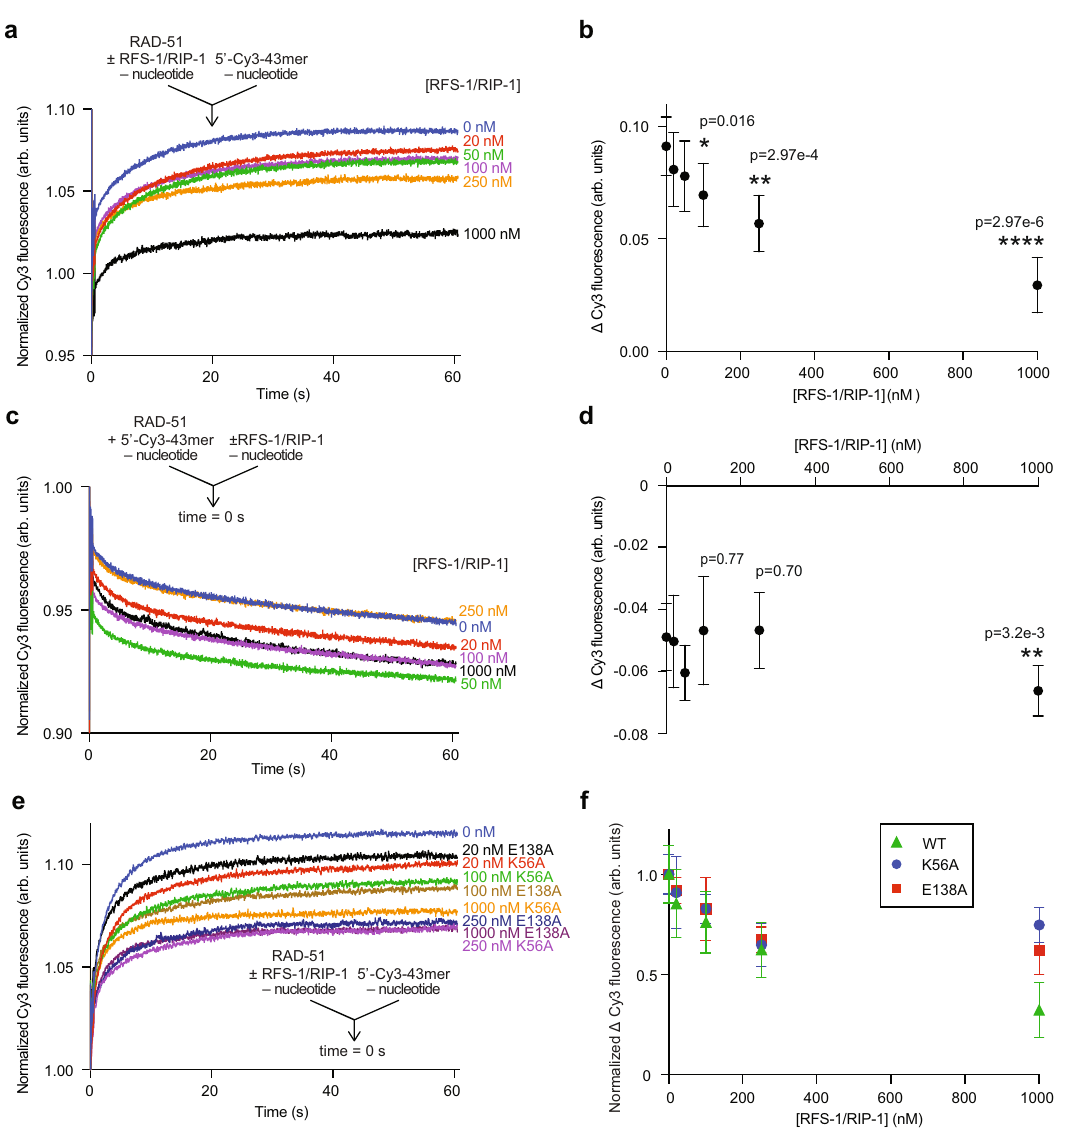
Fig. 2 RFS-1/RIP-1 inhibits the binding of RAD-51 to ssDNA in the absence of nucleotide cofactors. Average normalized Cy3-43mer fl uorescence pro fi les plotted as a function of time. The arrow indicates the components of the two syringes rapidly mixed at the 0 s time point in a stopped fl ow instrument. RAD-51 (1 μ M) was either pre-mixed with increasing amount of RFS-1/RIP-1 and then was mixed with 15 nM Cy3-43mer ssDNA ( n = 6 – 7) ( a ) or RAD-51 was pre-mixed with ssDNA and afterwards mixed with RFS-1/RIP-1 in the absence of nucleotide and analyzed in stopped fl ow machine ( n = 7 – 8) ( c ). Corresponding evaluations of average Δ Cy3 fl uorescence as a function of concentration of RFS-1/RIP-1 for the experiments in ( a and c ) are presented in ( b and d ) respectively (mean; errors: s.d.). p values are relative to RAD-51 alone data obtained by Student ’ s t test (two-tailed): * p < 0.05; ** p < 0.01; **** p < 0.0001. e Effect of Walker box mutants of RFS-1 (K56A and E138A) on RAD-51 in the absence of nucleotide. The experiment was done similarly as in ( a ) ( n = 5 – 8). f Normalized Δ Cy3 fl uorescence relative to RAD-51 alone at different RFS-1/RIP-1 mutant concentrations from data shown in ( e ). Data for wild-type RAD-51 are taken from ( b ) for comparison (mean, errors: s.d.). Source data are provided as a Source Data fi